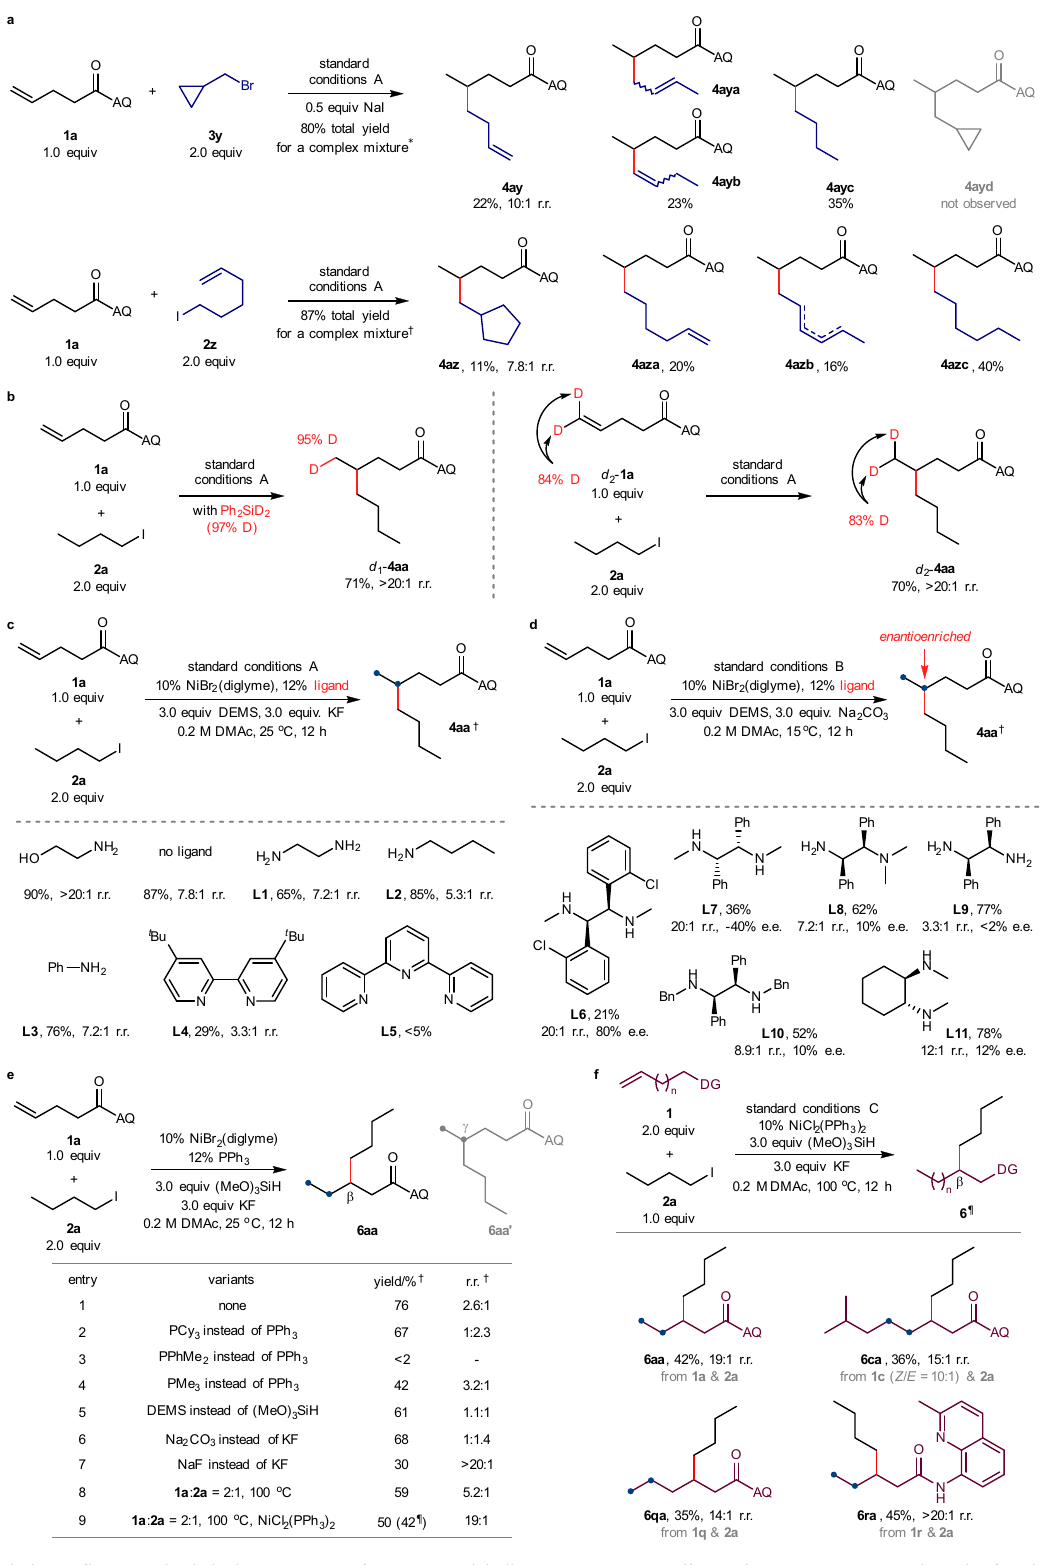
Fig. 4 Mechanistic studies. a Radical clock experiments. b Deuterium labelling experiments. c Effects of nitrogen-containing ligands. d Preliminary results of asymmetric synthesis. e Effects of phosphine-containing ligands. f Migratory β -selective hydroalkylation. Standard conditions A: as shown in Fig. 2, 0.2 mmol scales. Standard conditions B: determination of regioisomeric ratio was consistent with standard conditions A, 0.1 mmol scales. Standard conditions C: total yield for the mixture of all regioisomers. r.r. refers to the regioisomeric ratio, that of the major product to the sum of all other isomers. In most cases, a mixture of β - and γ -selective products was obtained; we could hardly observe other isomers. * 1 H NMR yield with dibromomethane as an internal standard. † GC yield with triphenylmethane as an internal standard. ¶ Isolated yield in parentheses.